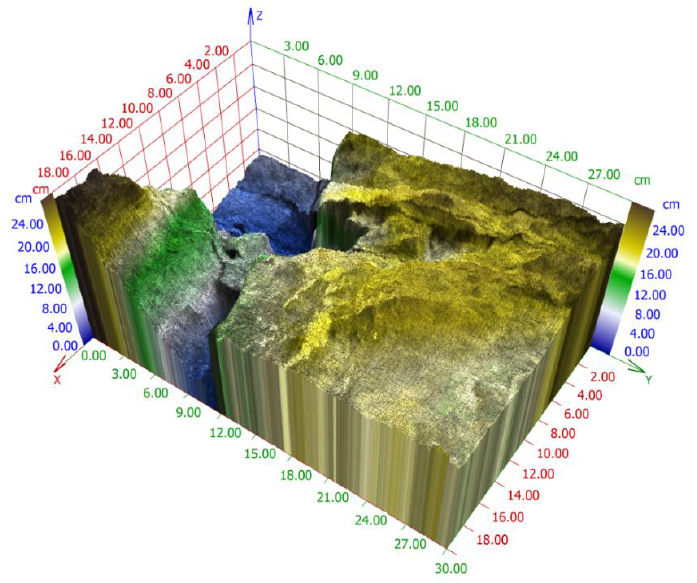
Figure 15. A 3D reconstruction of the limestone sample by data registration according to Section 4, with focusing criterion 28 and profile height calculations 29 and 30 (compare with Figure 5). The software was written by the first author. Taken from [45].